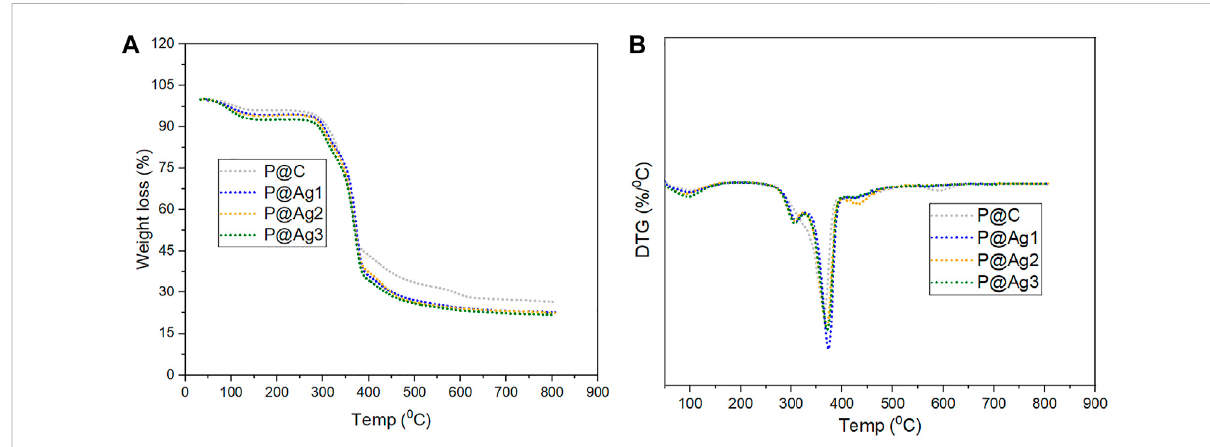
FIGURE 8 Thermal properties analysis of control and AgNP coated kraft papers: (A) TGA analysis and (B) DTG